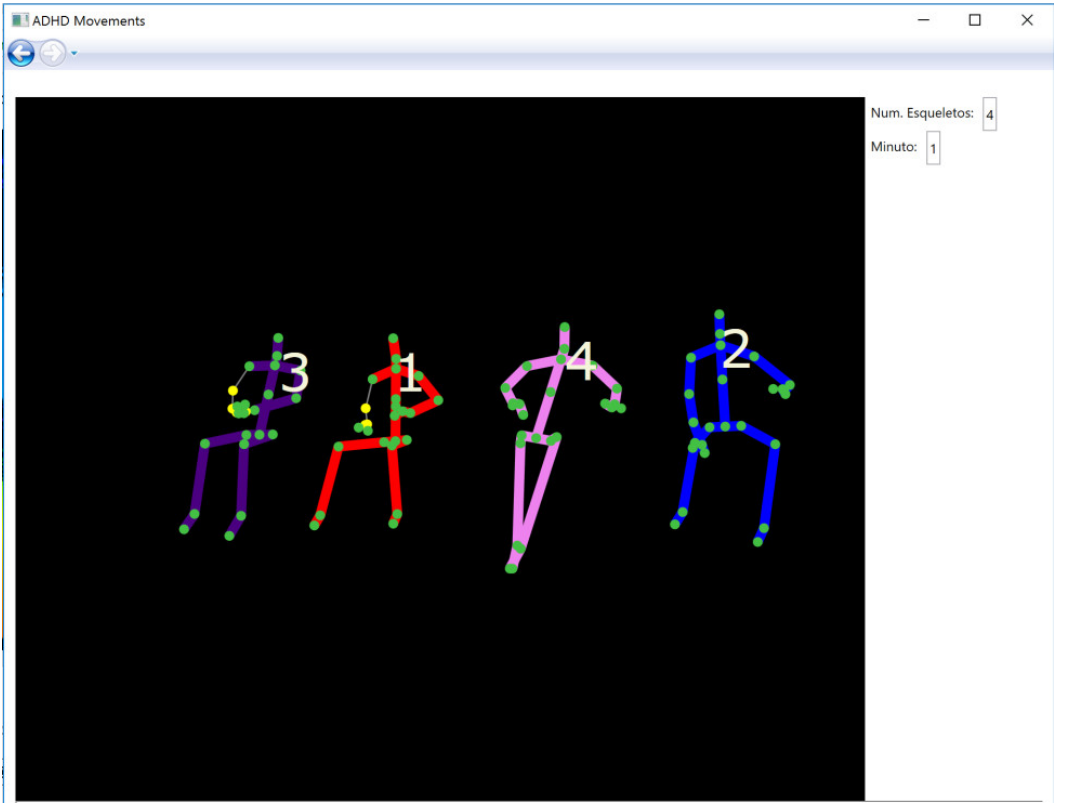
Figure 3. Screenshot of the application ADHD movements .